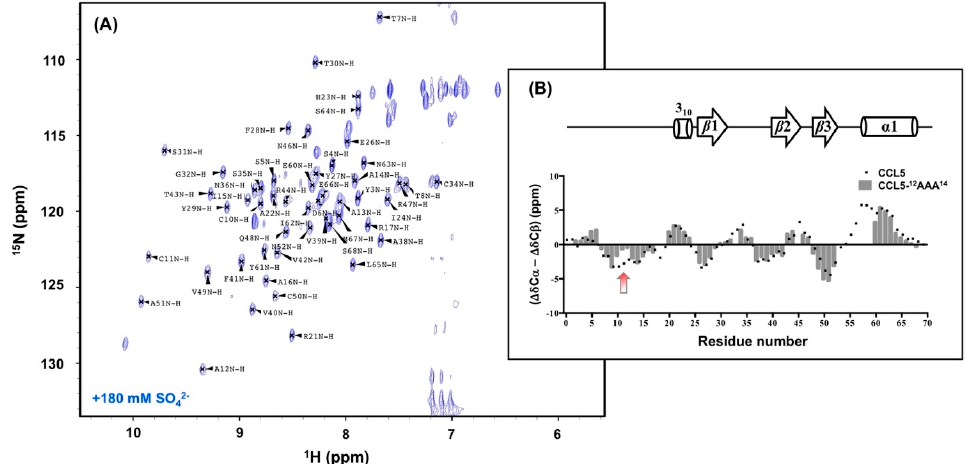
Figure 5. Secondary structure prediction of CCL5- 12 AAA 14 . ( A ) 1 H, 15 N-HSQC spectrum of CCL5- 12 AAA 14 with backbone resonance assignments. CCL5- 12 AAA 14 was prepared in 25 mM sodium acetate at pH 3.2, 150 mM sodium chloride and 180 mM ammonium sulfate. ( B ) The secondary structure of CCL5- 12 AAA 14 prediction evaluated by the parameter of ( Δδ C α – Δδ C β ). The secondary structure determined by X-ray crystallography is referenced on the top. The predication of the native